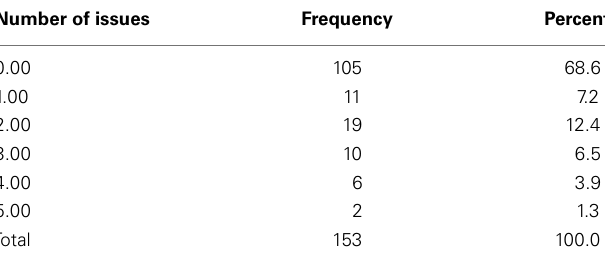
Table 7 | Number of issues encountered during the IVR Digit Span Backward